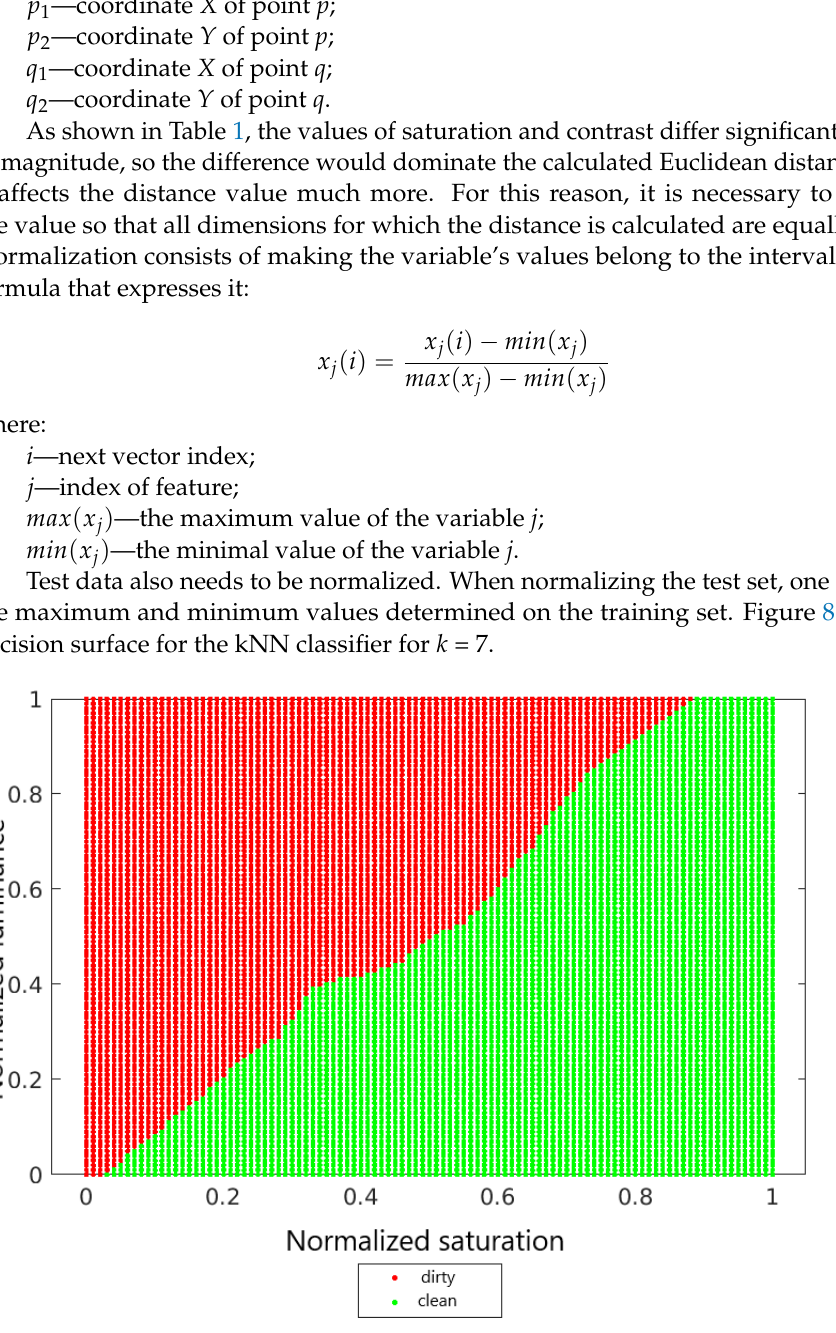
Figure 8. Decision area for the kNN classifier for k =